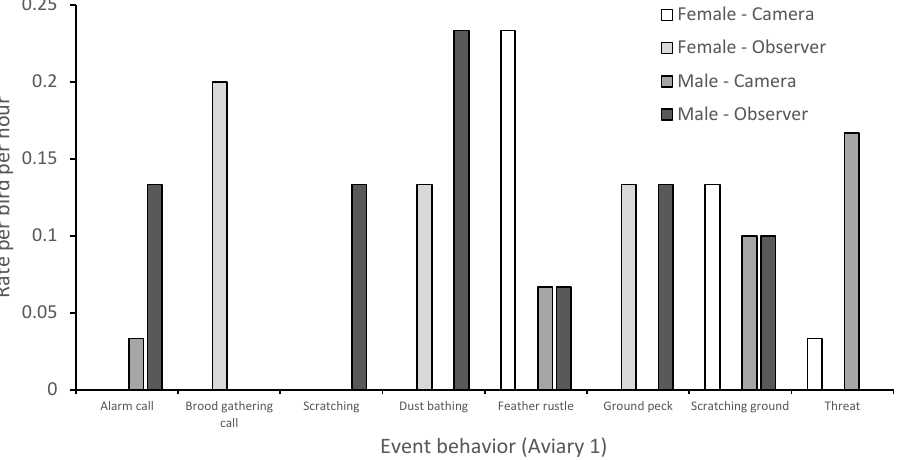
Figure 4. Rate of event behavior of pheasant pair housed in aviary 1, as compared between observer and camera conditions.